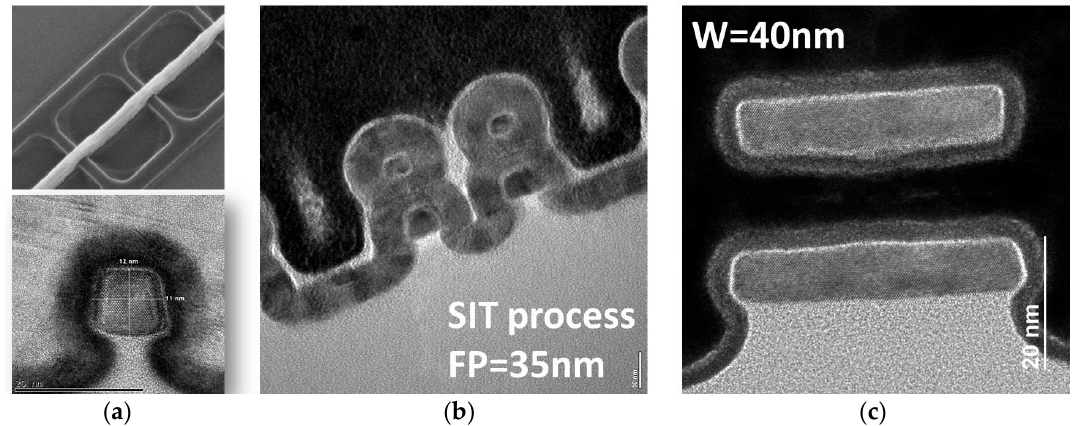
Figure 1. Example of transistor as addressed in SUPERAID7: ( a ) Trigate; ( b ) stacked nanowire; ( c ) stacked nanosheet.